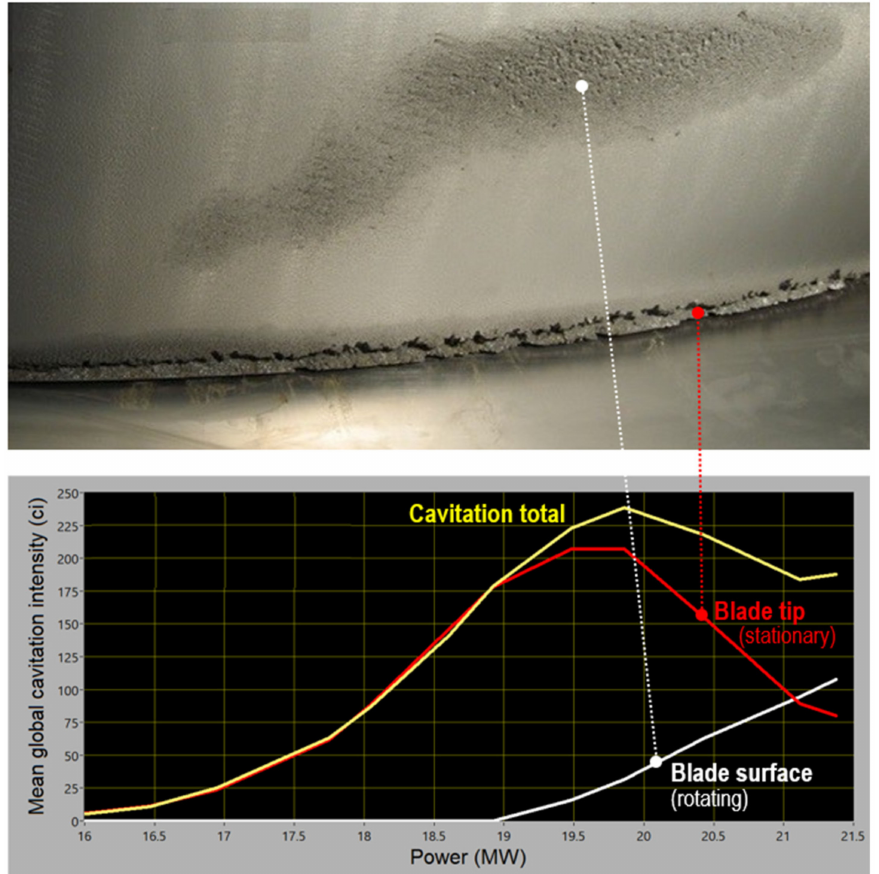
Figure 17. Cavitation-erosion photograph, typical of all four runner blades, as found in an overhaul, and the simplest quantitative description of the total cavitation intensity and the intensities of the two groups of